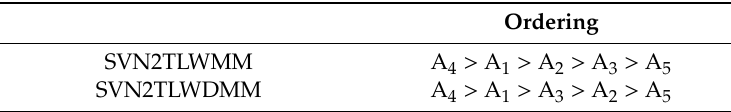
Table 4. Ordering of the green suppliers.